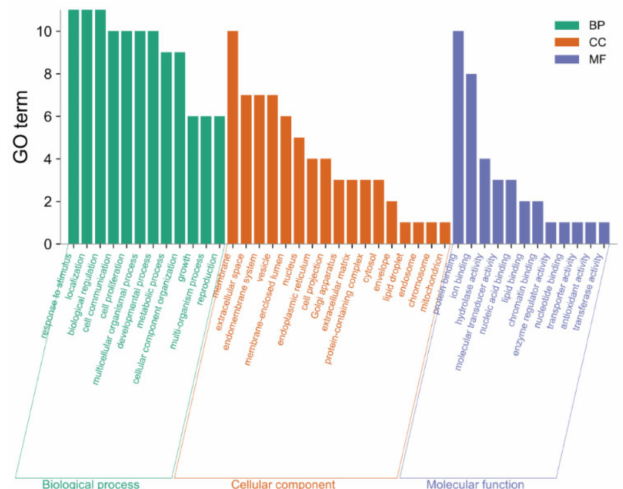
Figure 12. GO functional analysis